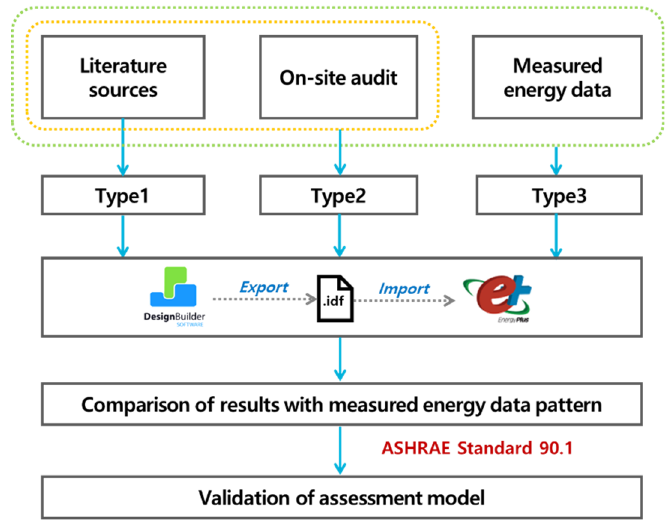
Figure 2. Assessment methods according to data acquisition level.